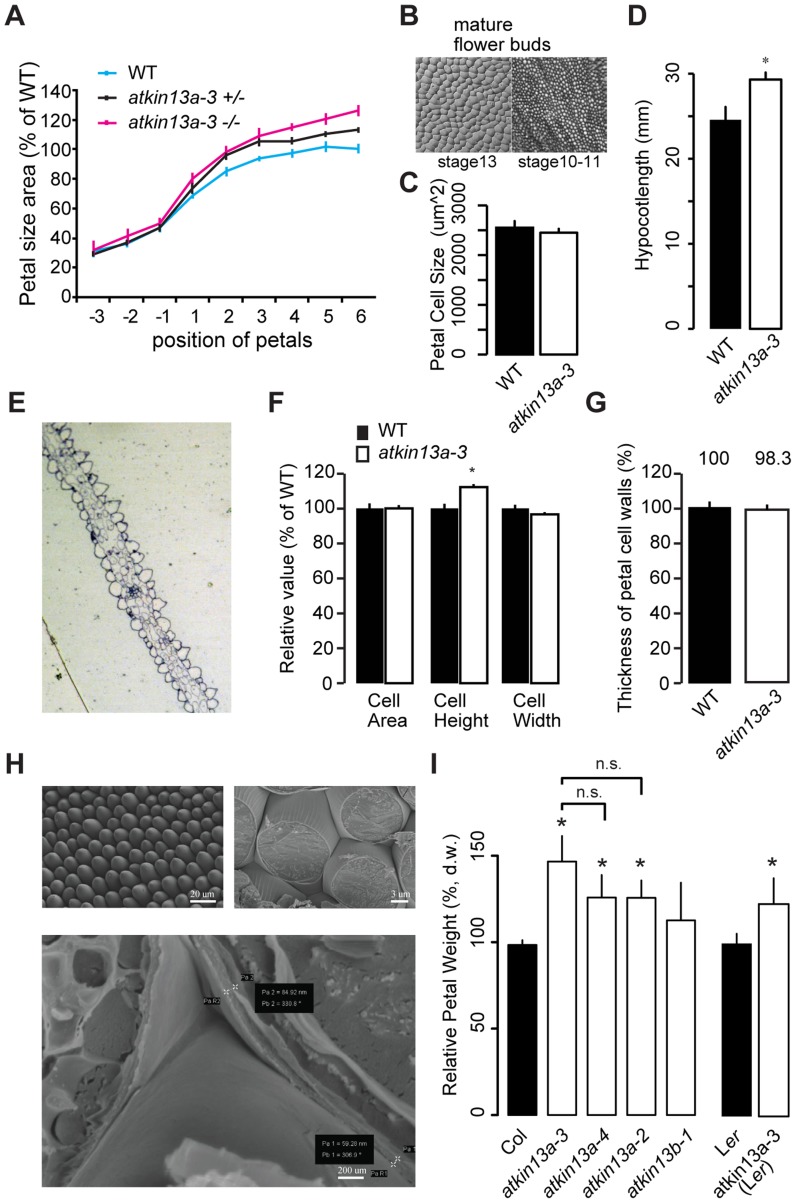
Increased postmitotic cell expansion in atkin13a mutants.(A) Developmental series of petal size for the indicated genotypes. Flower 1 represents the youngest open flower, while flower −1 is the oldest unopened flower bud. Values are normalized to the size of the wild-type petals from the oldest measured flowers. Values represent mean ± SEM (n<10 petals). (B) Gel-print images of wild-type petal cells from the indicated flower stages (after [71]). (C) Petal-cell size from stage 10–11 buds is not different between wild type and atkin13a-3 mutants. Values are mean ± SD of 50 petal cells each from more than 6 petals. (D) Etiolated hypocotyls are longer in atkin13a-3 mutants than in wild type. Values are mean ±SD of 10 plants. 8-day old seedlings were measured. (E) Toluidine-blue stained cross section through a mature wild-type (left) and a mature mutant petal (right). Adaxial side is to the right in both images. (F) Cross-sectional cell area, cell height and cell width from petals of wild type and atkin13a-3EMS mutants. Values are normalized to wild-type values and represent mean ± SD of 50 petal cells. (G) Thickness of petal-cell walls as measured from scanning-electron micrographs. Values are mean ± SEM of 100 petal cells from 10 petals, normalized to the wild-type value. (H) Scanning-electron micrographs of wild-type petals before (top left) and after (top right and bottom) freeze fracturing. Bottom image also indicates how measurements of cell-wall thickness were taken (pairs of white crosses). Length of scale bars is indicated. (I) Petal dry weight of the indicated genotypes. Values are mean + SD from 3 replicates of 50 petals each, normalized to the respective wild-type values. Differences between the three atkin13a mutant alleles are not statistically significant (n.s.). Asterisk indicates significant difference from wild-type at p<0.05 (with Bonferroni correction where appropriate).